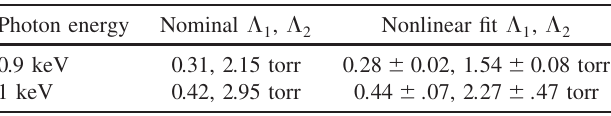
TABLE II. Nominal (middle column) and measured (right column) second harmonic attenuation lengths for the gas detec- tor. The nominal and fitted attenuation lengths match well for the fundamental, but in general the fitted second harmonic values are lower than